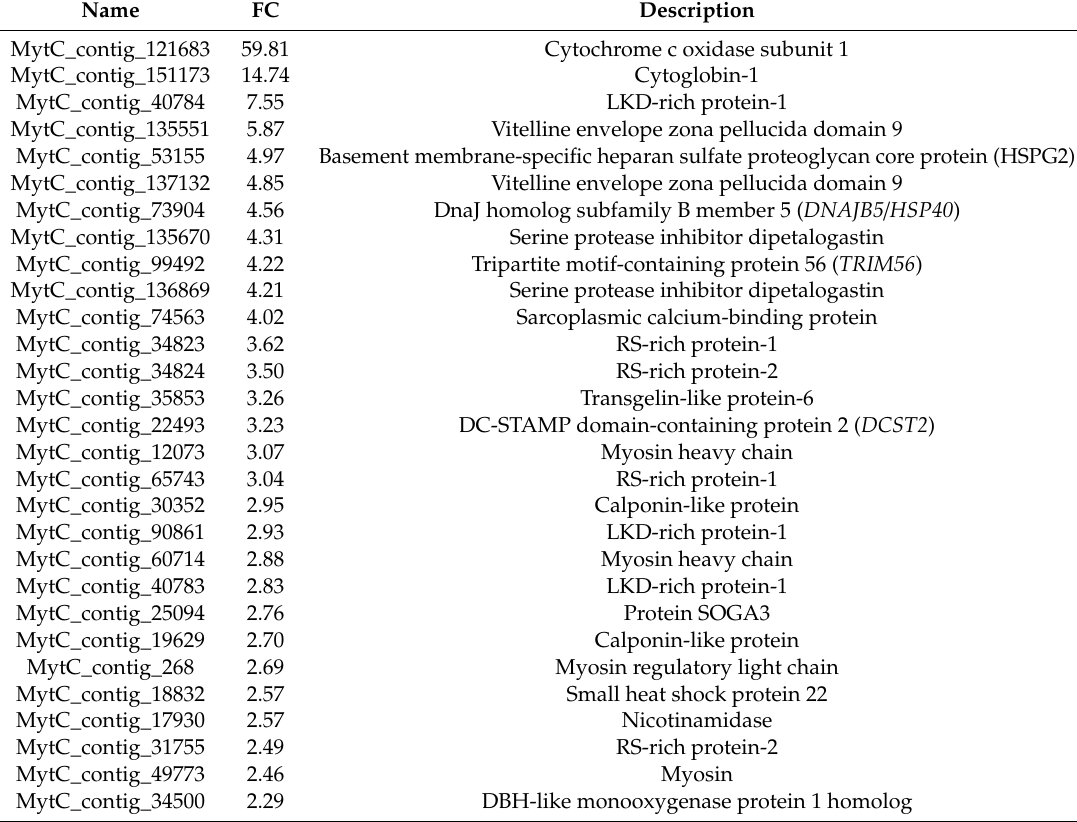
Table 2. Top annotated DEGs after a myticin C treatment. FC, fold